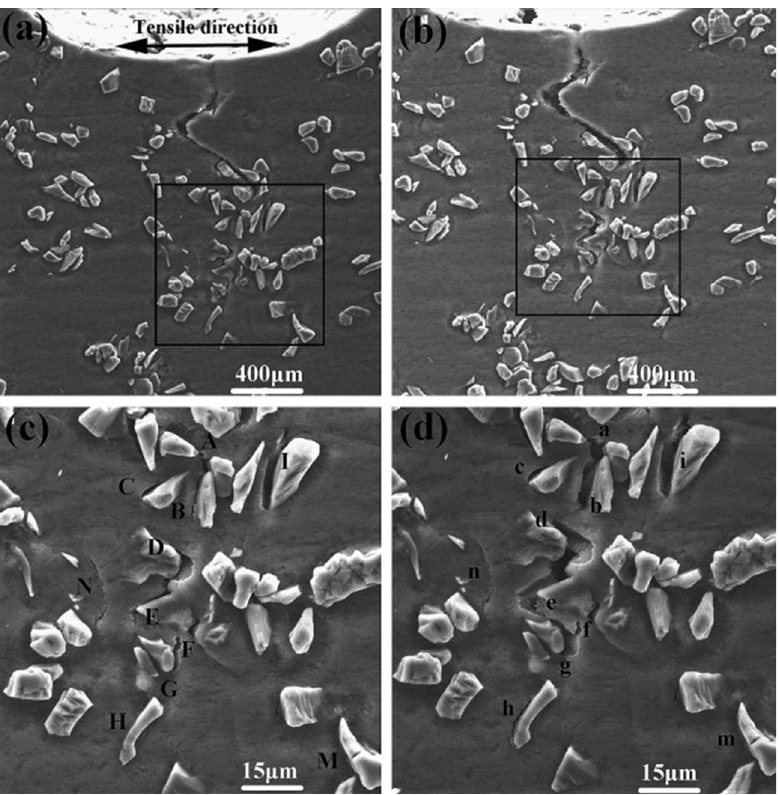
Figure 2: ( a ) Cracks ahead of the notch at the “ small ” strains; ( b ) corresponding image of ( a ) at “ large ” strains. ( c and d ) Further magni fi cation of the rectangular regions in ( a ) and ( b ) , respectively [ 95 ]